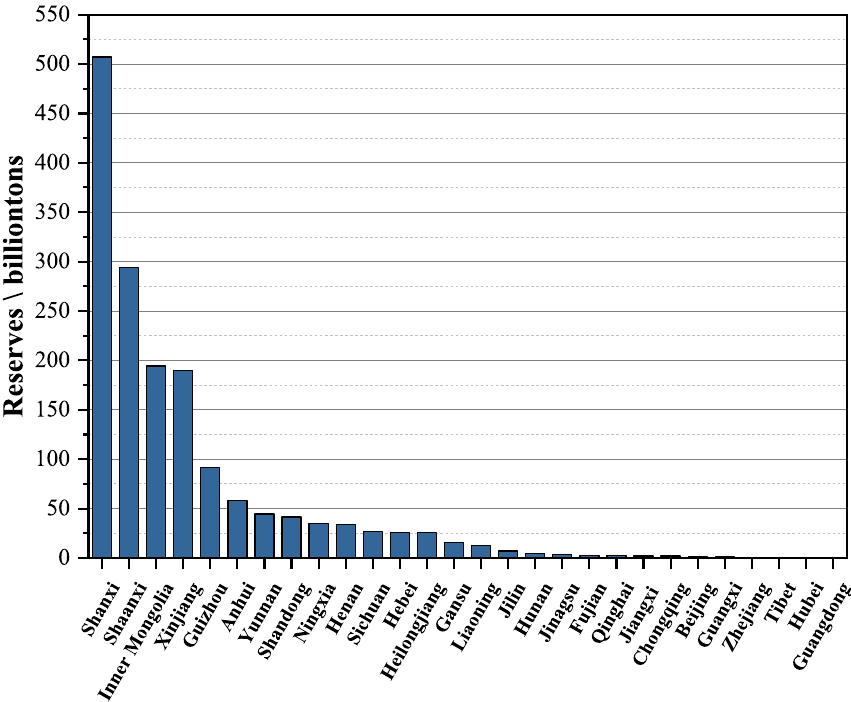
Fig. 1 Distribution of coal reserves by province and